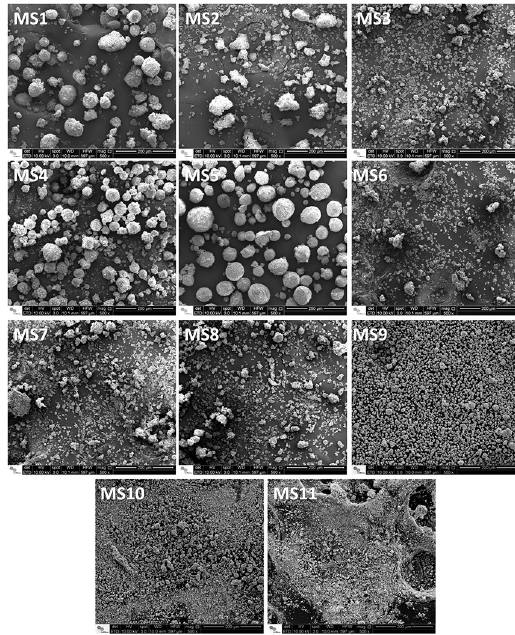
Figure 6: SEM micrographs presenting the microspheres obtained by the different processing conditions tested in the factorial design.